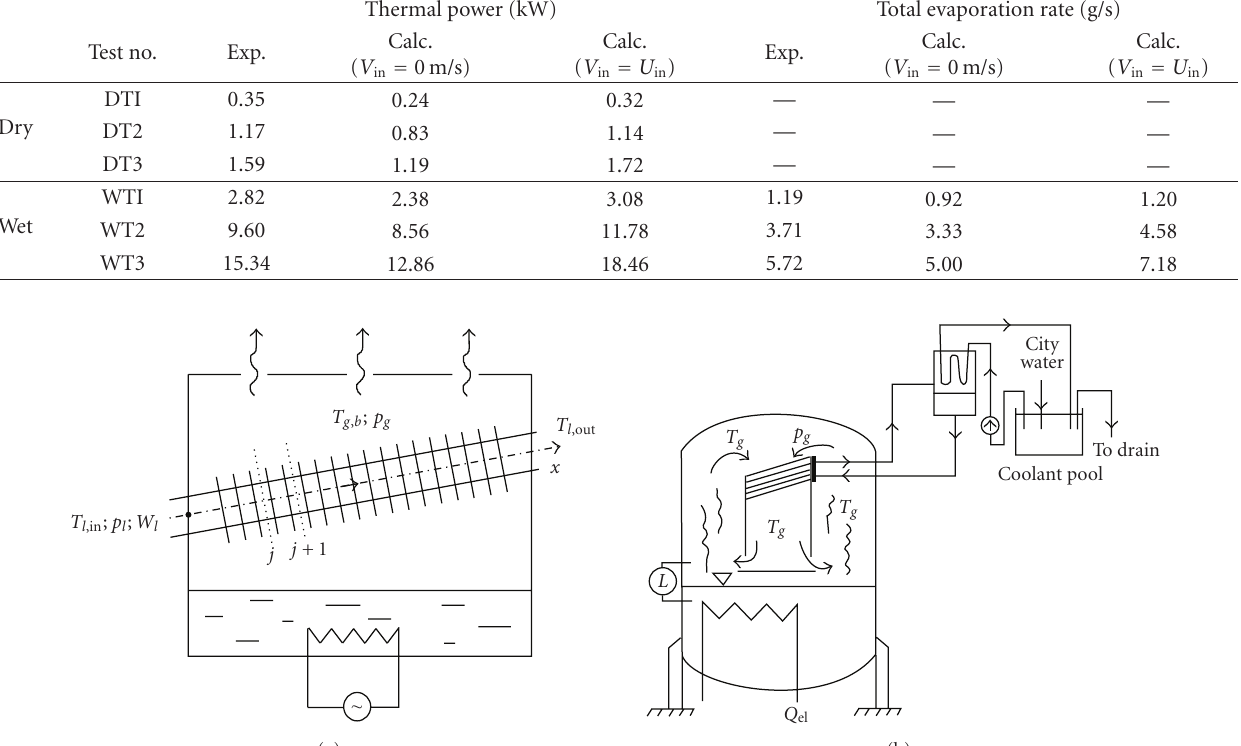
Figure 7: Sketches of the experimental apparatuses adopted by CISE for single tubes and full compact heat exchanger mock-ups [11].